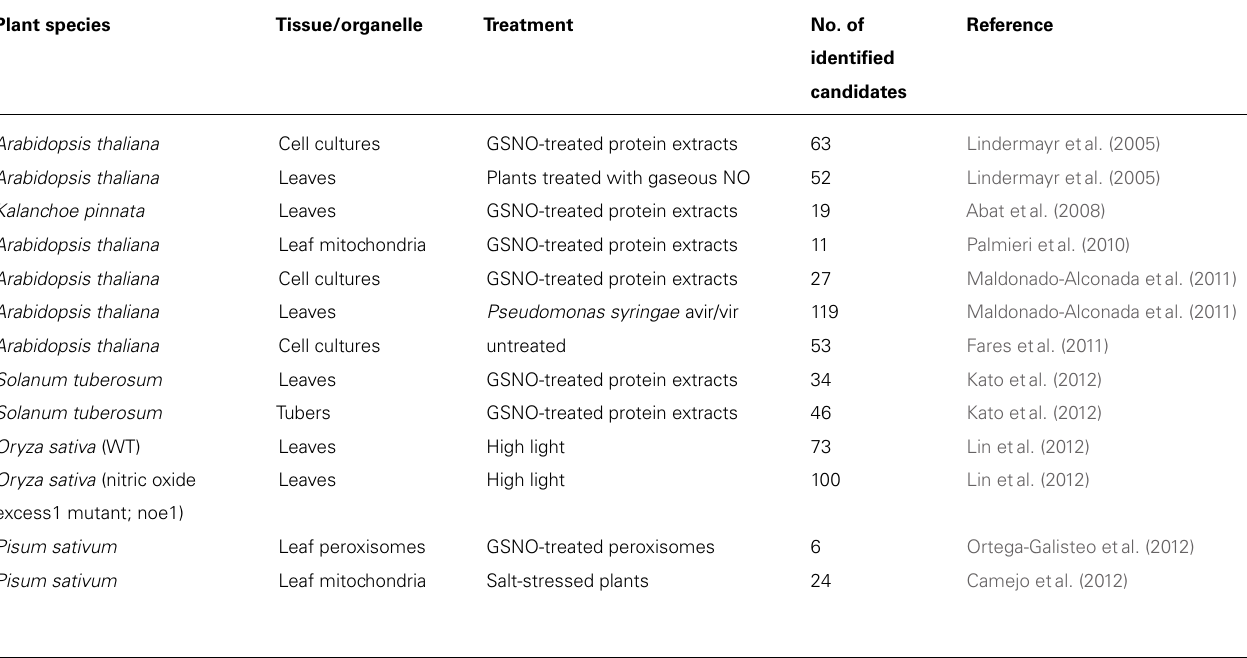
identified candidates